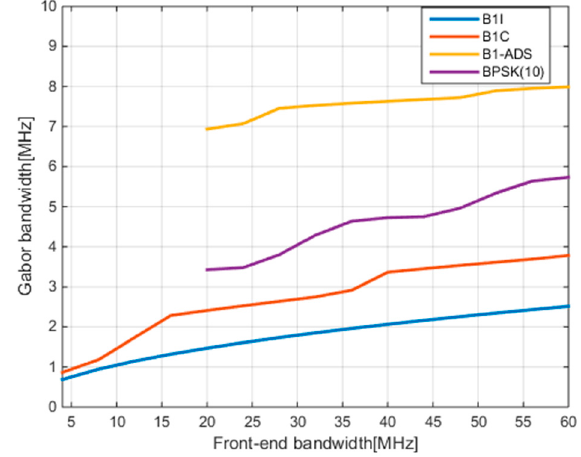
Figure 2. The Gabor bandwidths of B1-ADS and other signals.